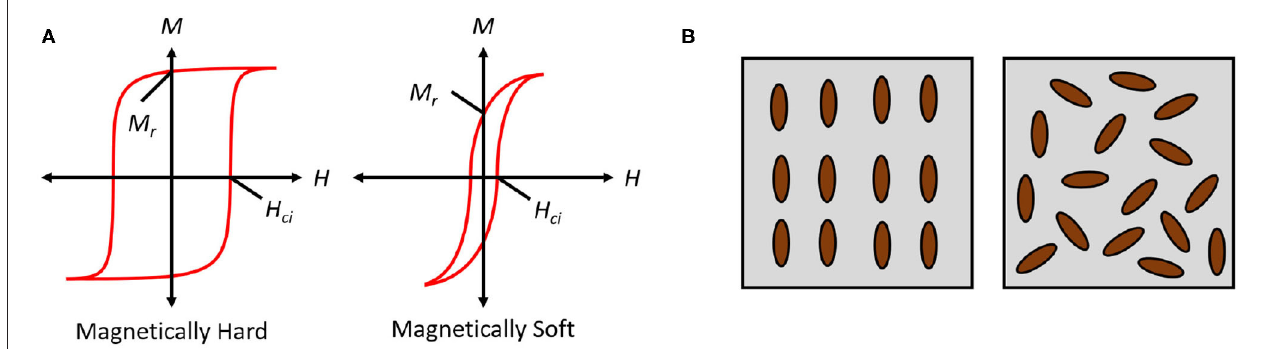
FIGURE 1 | (A) The magnetization, M , vs. the applied field, H , for a hard (left) and soft (right) magnetic material. On these plots, M r represents the remanence magnetization (i.e., magnetization in the absence of a field). H ci represents coercivity. (B) A representation of elastomers cured with (left) and without (right) an applied field during curing. Application of a field yields an anisotropic ME with particles aligned in the direction of the applied field. In the absence of a field, an isotropic ME, with randomly oriented particles, is